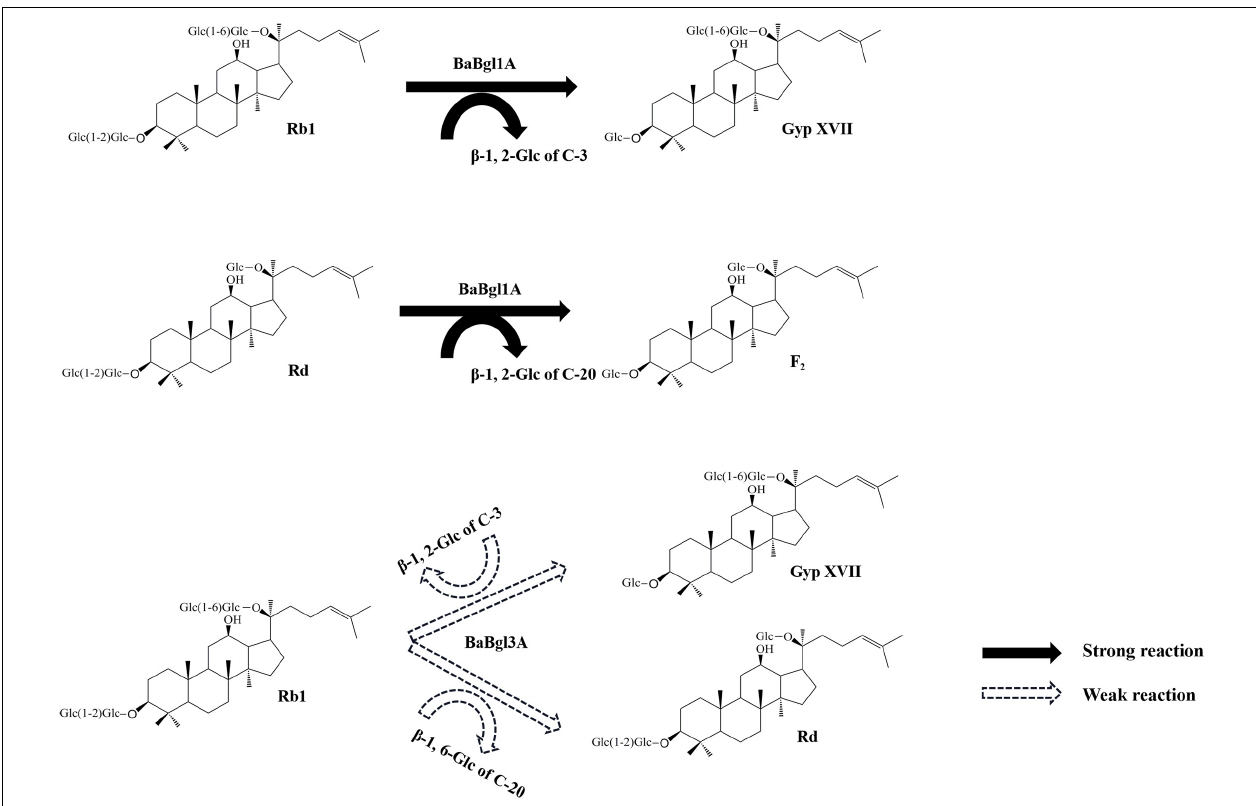
FIGURE 7 | Biotransformation pathways of ginsenosides Rb1 and Rd by recombinant BaBgl1A and BaBgl3A.